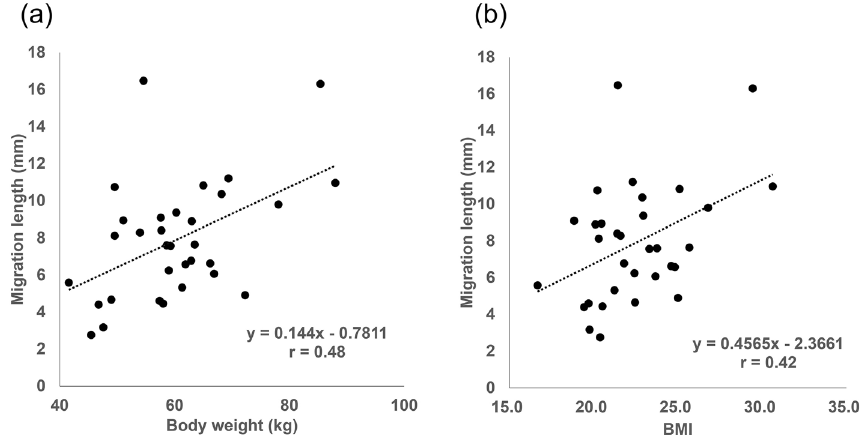
Figure 3. Scatter plots of correlation analysis. Scatter plots for the migration length of the tip of the coccyx versus body weight ( a ) and body mass index (BMI) ( b ), with linear regression lines (dotted lines). The migration length exhibited a moderate correlation with increased body weight ( r = 0.48, p = 0.0054) and increased BMI ( r = 0.42, p =